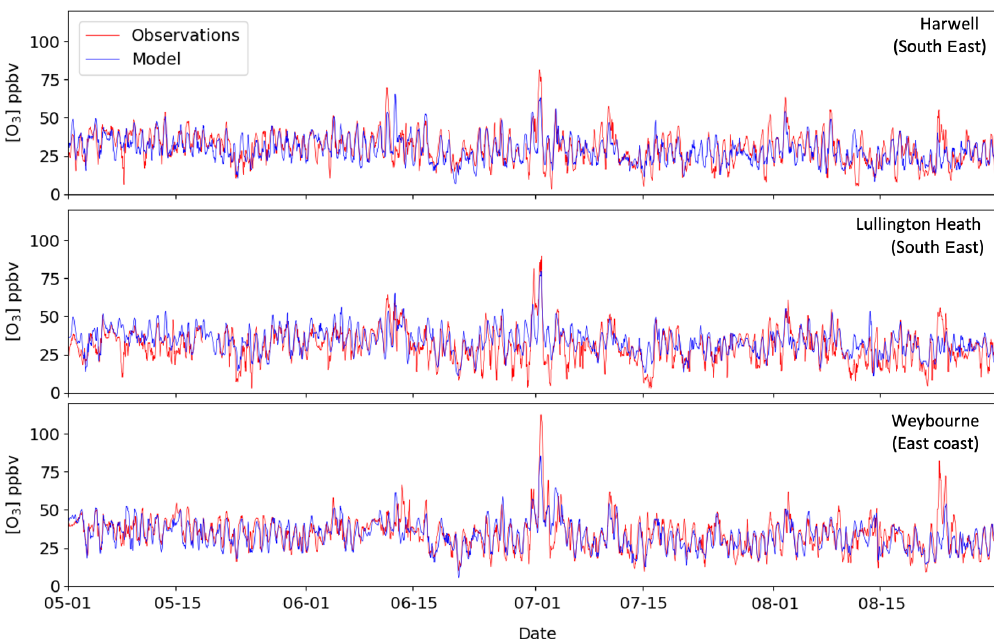
Figure 2. Modelled and observed hourly O 3 mixing ratios from May to August 2015 at three sites over the UK. The date is given in the format month-day.